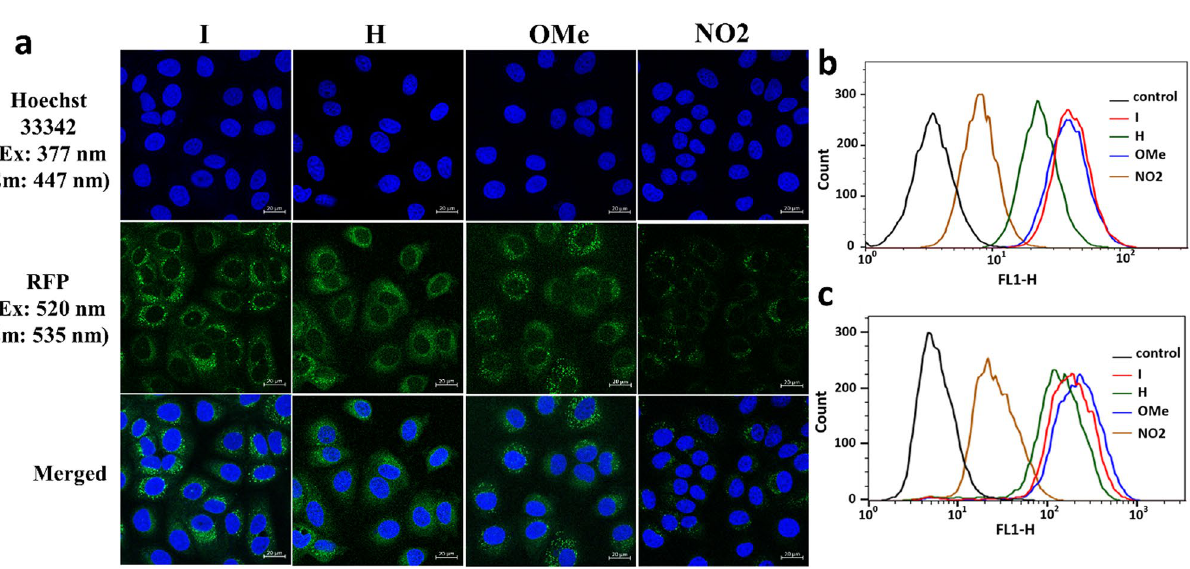
Figure 6. Cell selectivity and imaging of lactose-functionalized BODIPY PSs. Fluorescence images of Huh-7 cells were captured after a 2 h incubation with 2 µM of I, H, OMe, and NO2-NPs . After incubation, cell nuclei were stained with Hoechst 33,342 dye for 10 min. Images were captured with a 40 × objective lens and fluorescence optics (excitation at 520 nm for I, H, OMe , and NO2-NPs and 377 nm for Hoechst 33,342; and emission at 535 nm for I, H, OMe, and NO2-NPs and 447 nm for Hoechst 33,342). Scale bar = 20 μm ( a ). The fluorescence-activated cell sorting (FACS) analysis of HeLa ( b ) and Huh7 cells ( c ) treated with 2 μM of BODIPY I , H , OMe , and NO2 .The incubation time was 2 h for all BODIPY